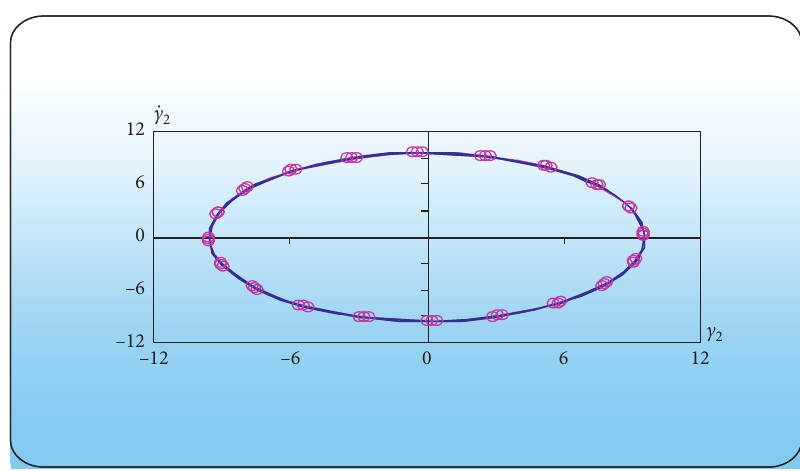
Figure 4: The stability of the analytical and numerical solutions _ c